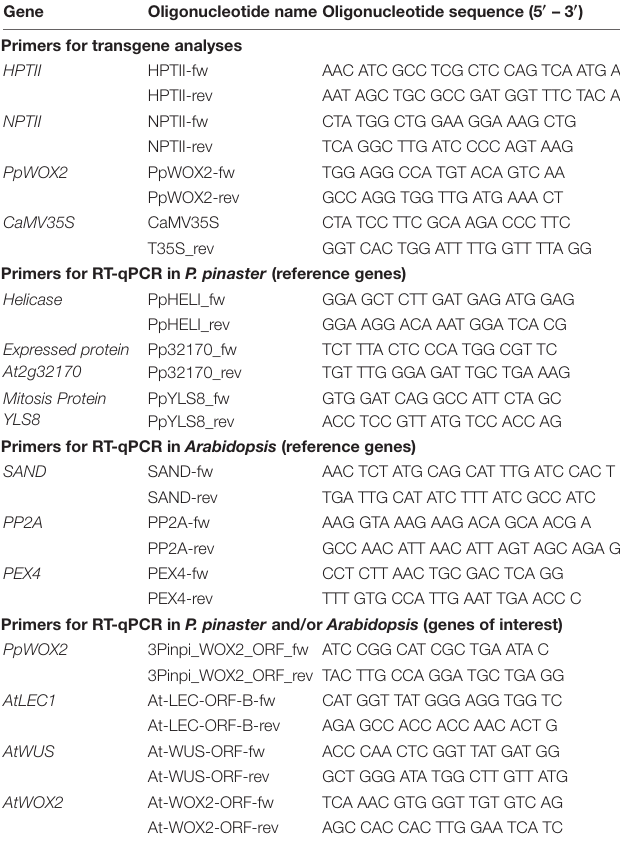
TABLE 1 | List of gene-specific primers used for transgene analyses and reverse transcription quantitative (RT-q) PCR in Pinus pinaster and Arabidopsis. Gene Oligonucleotide name Oligonucleotide sequence (5 (cid:48) – 3 (cid:48) ) Primers for transgene